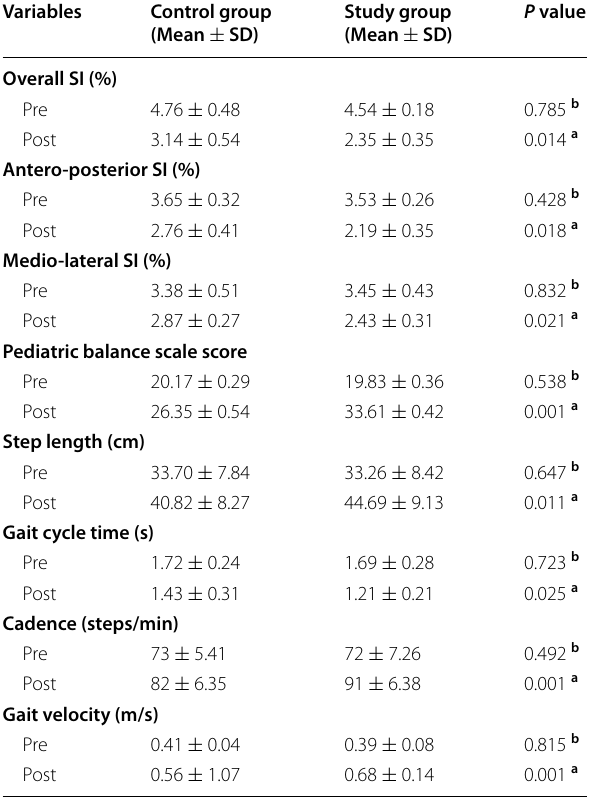
Table 2 Comparison between the two groups (control and study), for the mean values of all measured variables, at baseline and immediately after 12 weeks of